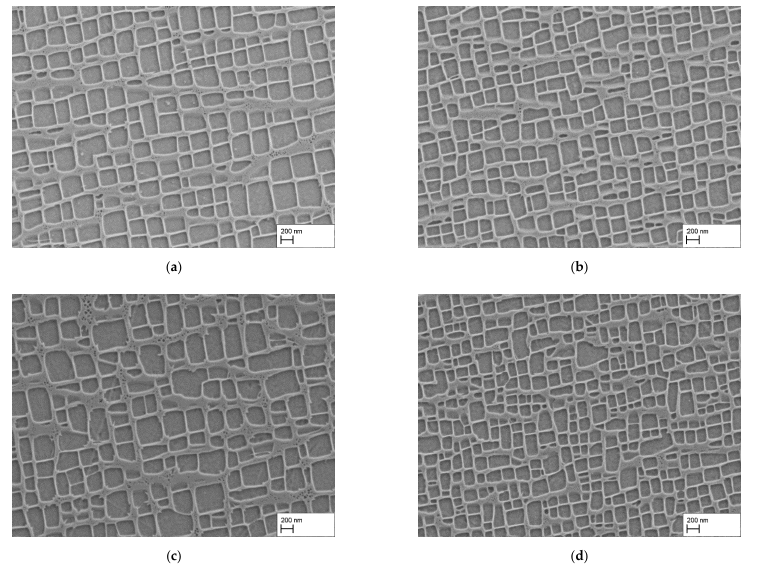
Figure 2. γ / γ′ -microstructure after homogenization and precipitation heat treatments: ( a ) HT/AC + 1140 °C/2 h/AC, ( b ) HT/AC + 1140 °C/30 min/AC, ( c ) HT/WQ + 1140 °C/2 h/AC, ( d ) HT/WQ + 1140 °C/30 min/AC. Table 3. γ′ -edge length and γ′ -volume fraction of the AC and WQ samples with additional heat treatment at 1140 °C and a reduced precipitation time. Heat Treatment